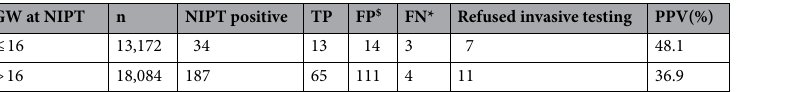
Clinically significant CNVs TP FP/FPR PPV TN FN/FNR NPV Classical